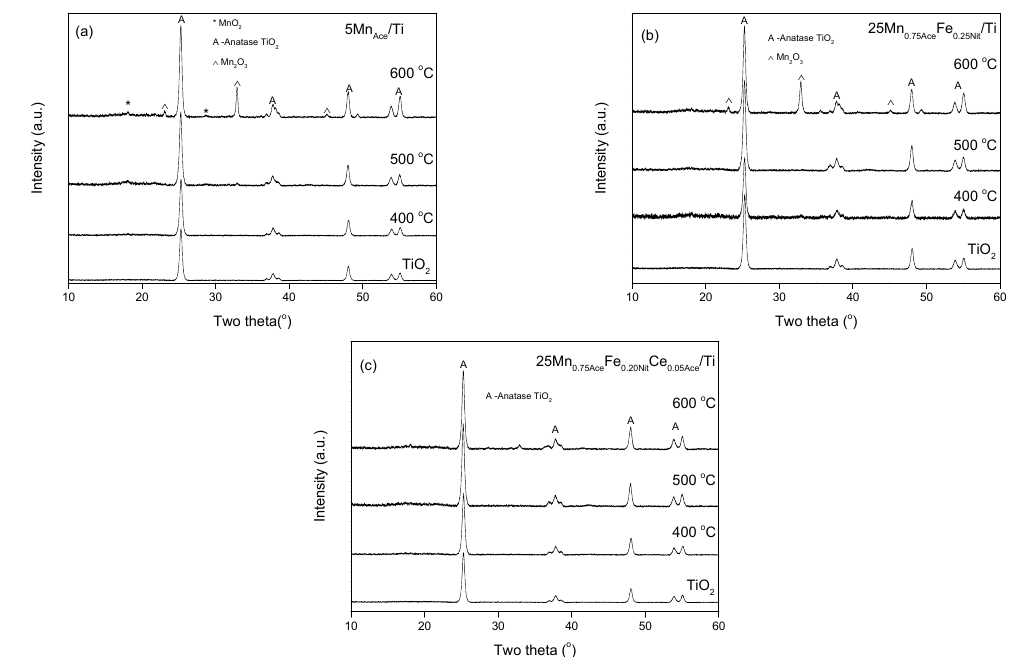
Figure 7. XRPD patterns of catalysts calcined at various temperatures: ( a ) 5MnAce/Ti; ( b ) 25Mn 0.75Ace Fe 0.25Nit /Ti; ( c ) 25Mn 0.75Ace Fe 0.20Nit Ce 0.05Ace /Ti.